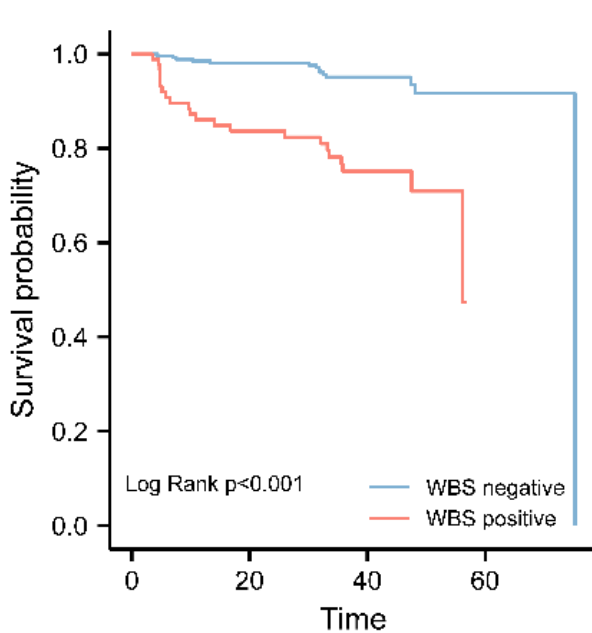
Figure 1. Prognostic value of RAI-avid lymph node metastasis revealed on Rx SPECT/CT. We divided the patients into two subgroups according to the results of sTg in